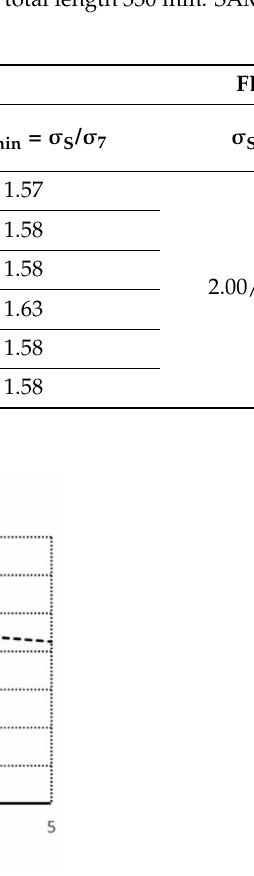
Figure 20. Dimensionless post-buckling equilibrium paths for the TH-channel of total length 330 mm.